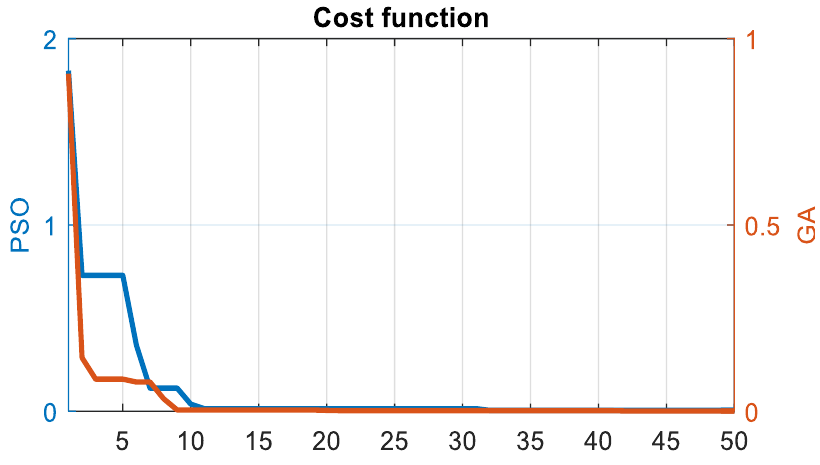
Figure 23. Cost value for PSO and GA algorithm.